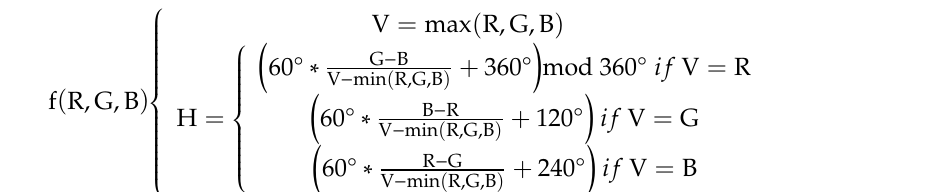
The transformation function f: SWIR2 × NIR × RED → H × V is a standardized colorimetric transformation from RGB to HV components of the HSV color space, where SWIR2 = R, NIR = G